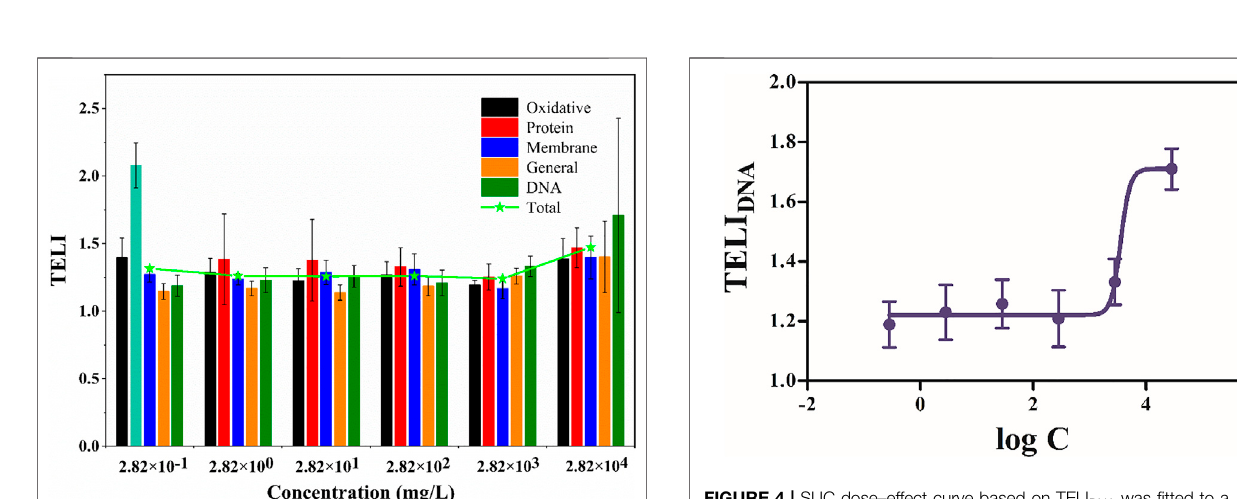
FIGURE 2 | The TELI values corresponding to each genetic stress response upon exposure of E. coli to various SUC concentrations.